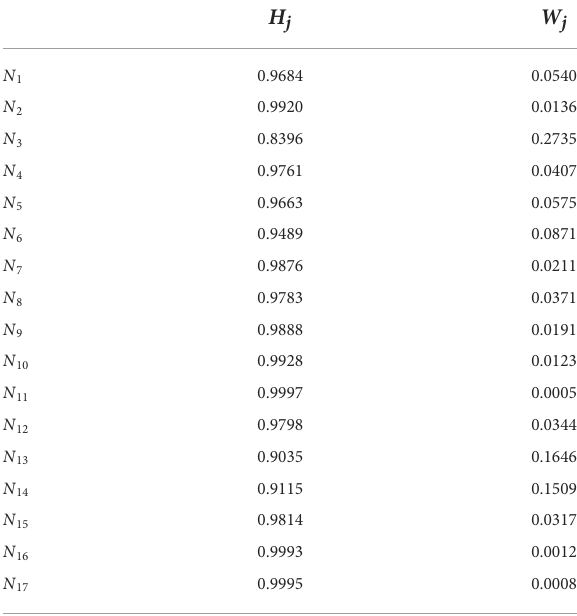
TABLE 9 Entropy values and objective weights of evaluation